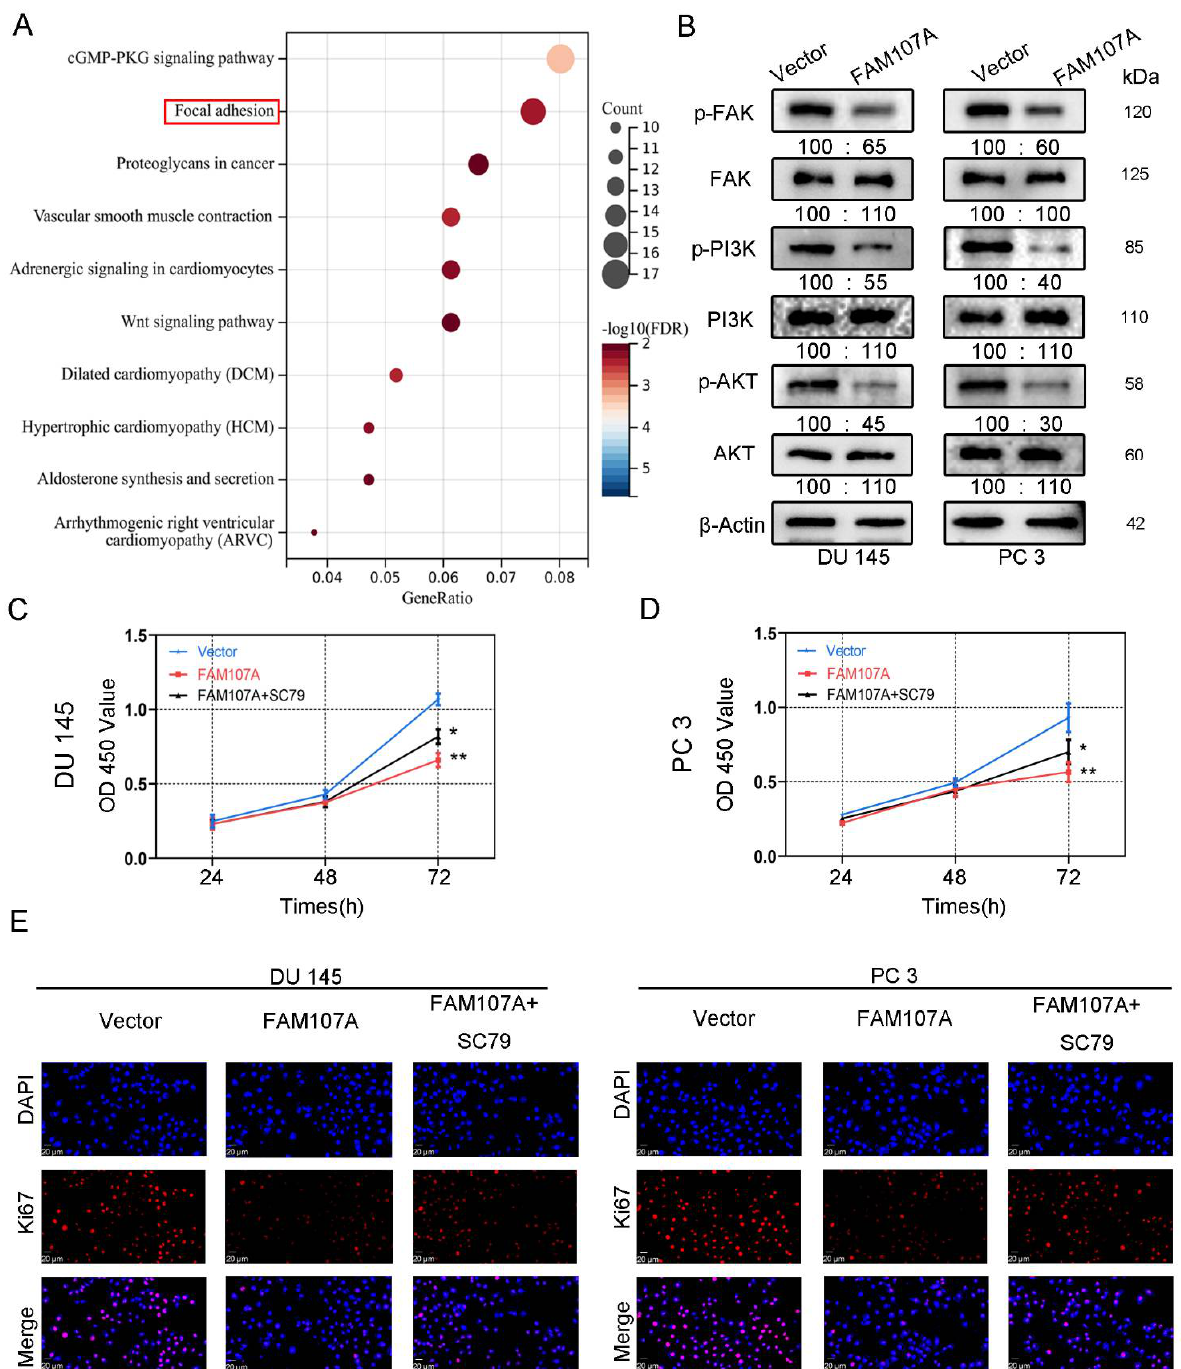
Figure 7. FAM107A affects PCa cell proliferation through FAK/PI3K/AKT pathway. ( A ) Enrichment results of the KEGG pathway suggest that FAM107A may be involved in PCa progression through the FAK/PI3K/AKT pathway. ( B ) Western blotting analysis of p-FAK expression and expression of downstream signaling pathway proteins p-PI3K and p-AKT. ( C ) AKT activator SC79 could partially restore the inhibition of cell proliferation ability after FAM107A overexpression. ( D ) The CCK-8 experiment was used to compare the proliferation activity of PC3 and DU145 cells in different groups. ( E ) An immunofluorescence assay was performed to detect the expression of Ki67 in each group of cells at a magnification of 400×. ** for p < 0.01, and * for p < 0.05.